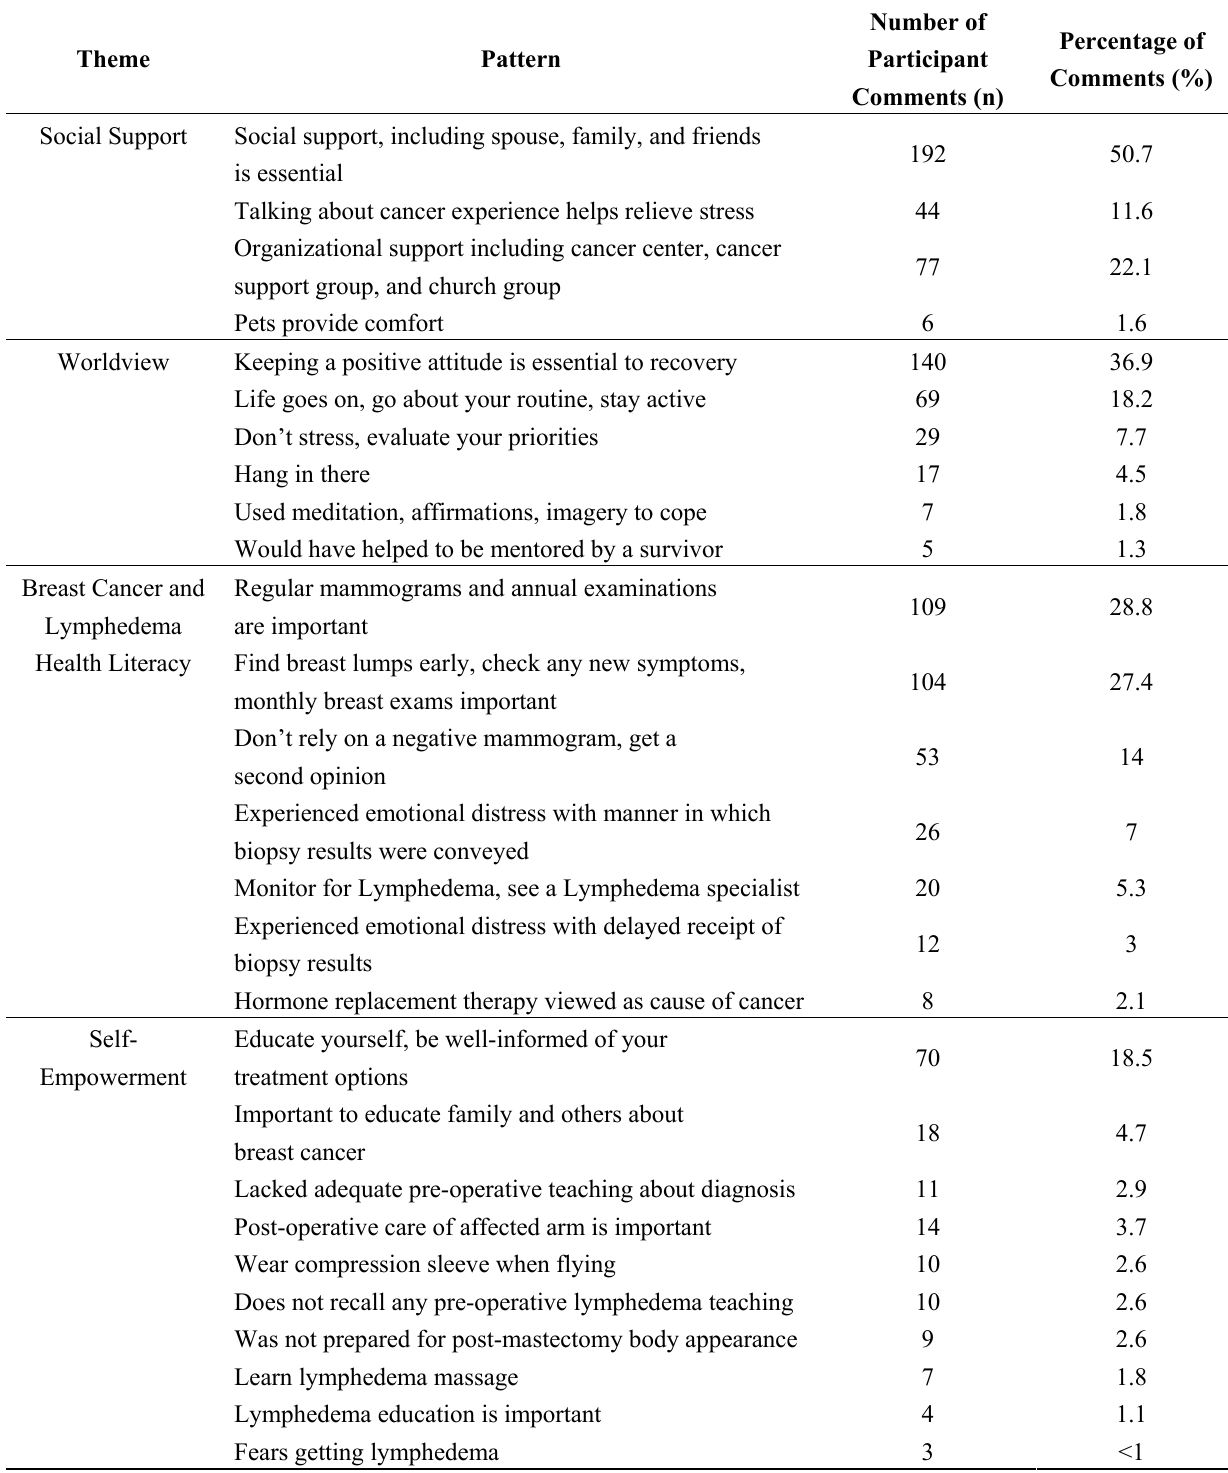
Table 2. Patterns and Themes of Survivors’